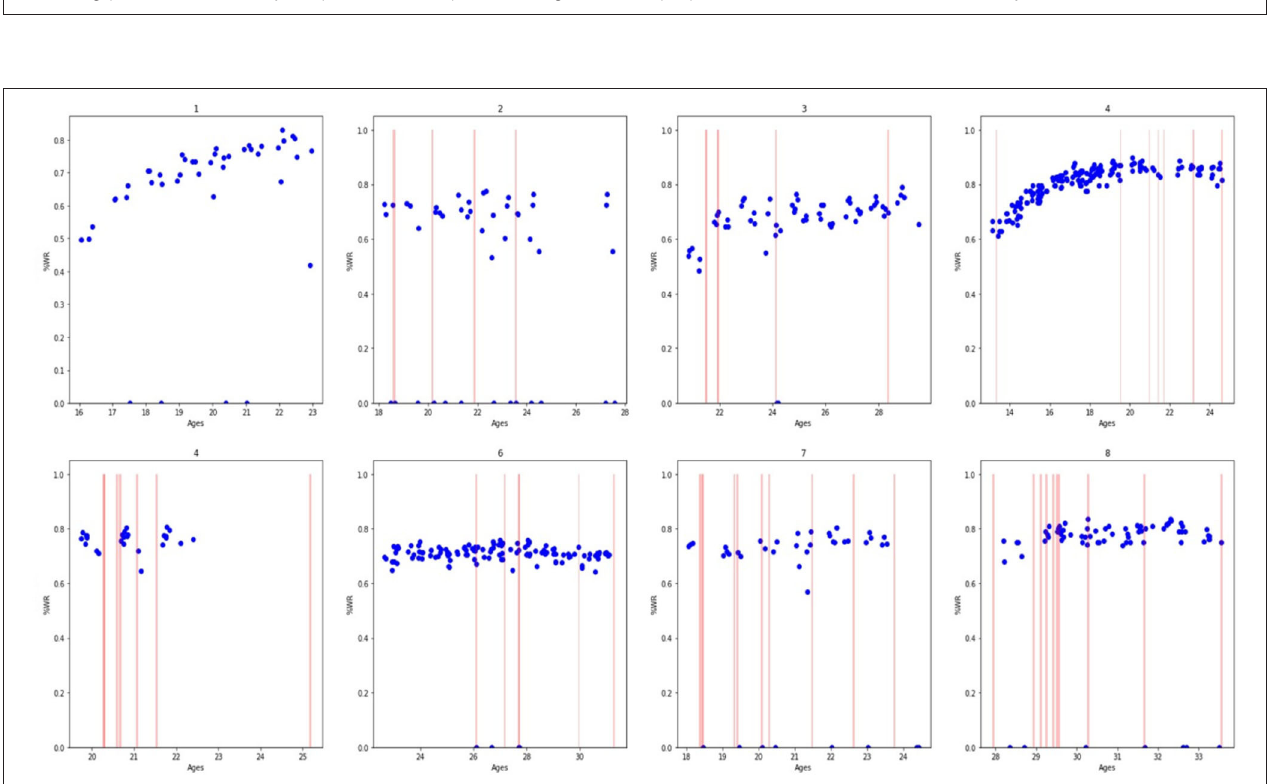
FIGURE 2 | Evolution of the performances (represented by the percentage of the World Record, in blue dots) for each included athlete over time (represented by the athlete’s age) with occurrence of time loss injuries (in red vertical line). The meaning of numbers (1–8) are the number of each athlete of the study.